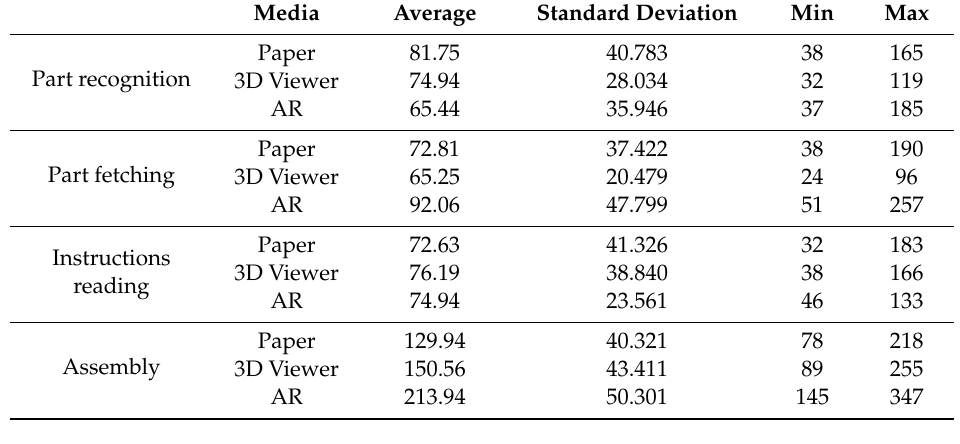
Table 4. Experimental result of each step time in seconds.